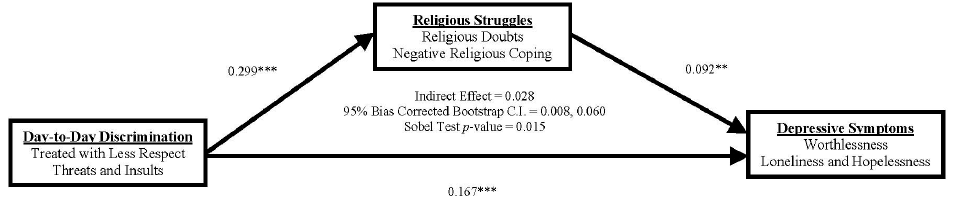
Figure 2. Empirical Model Linking Day-to-Day Discrimination and Depressive Symptoms with Religious Struggles.